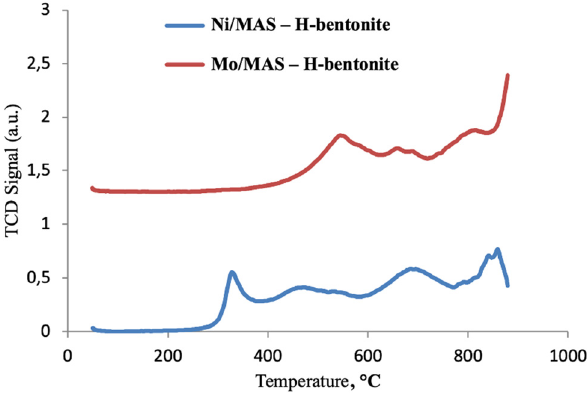
Figure 8: Temperature - programmed hydrogen reduction ( TPR - H 2 ) of Ni/MAS - H - bentonite and Mo/MAS - H - bentonite